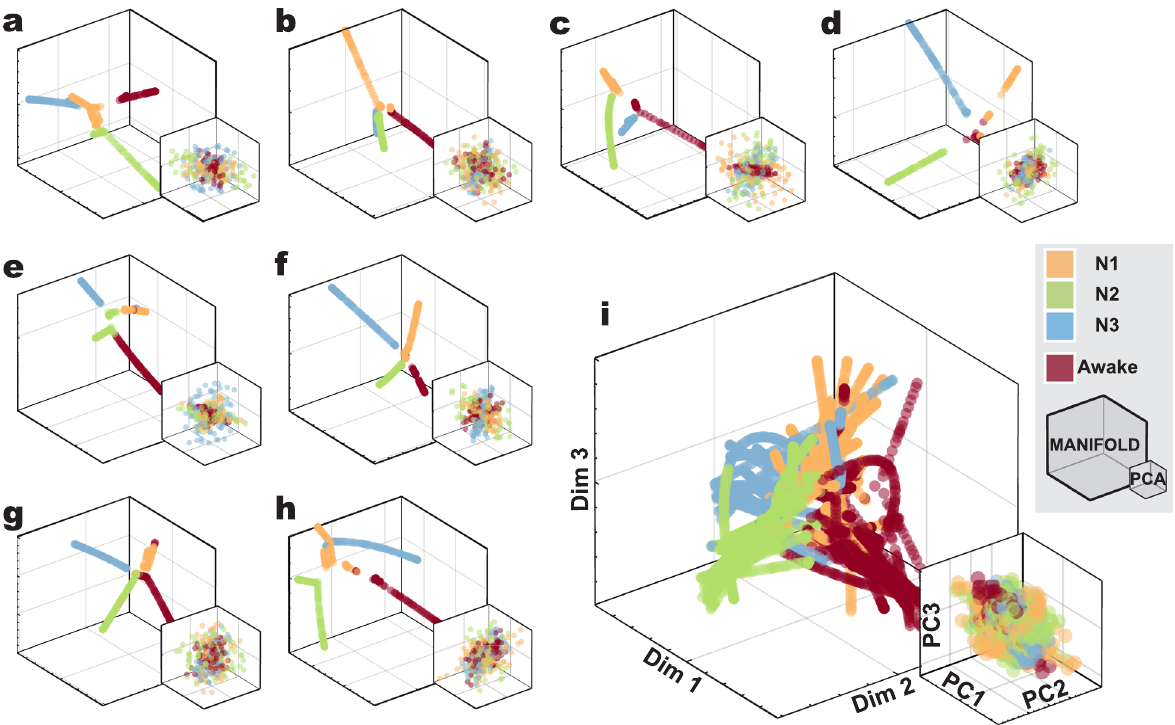
Fig. 2 Representation of the brain activity fMRI BOLD data during wakefulness and sleep embedded in lower-dimensional spaces. The plots show the data embedded into the three fi rst dimensions of the intrinsic manifold (large coordinate system) and into the three principal components derived from PCA (small coordinate system). a – h Each separate coordinate system corresponds to the data of eight different participants, embedded individually. i Intrinsic manifolds from all 18 participants, aligned jointly into the group manifold. For all cases, nonlinear embedding of the data into their intrinsic manifold led to well-structured intrinsic manifolds with a clearer separation of different sleep stages (as de fi ned through polysomnography) compared to the linear embedding given by